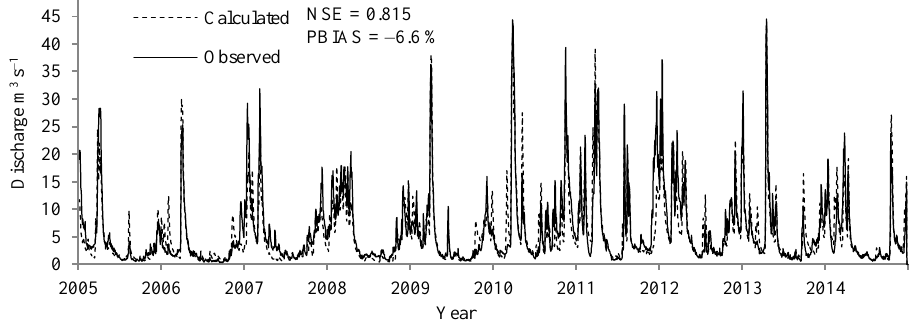
Fig. 4. Observed and calculated average daily discharge in the outlet of the Berze River during the time period of 2005–2014.